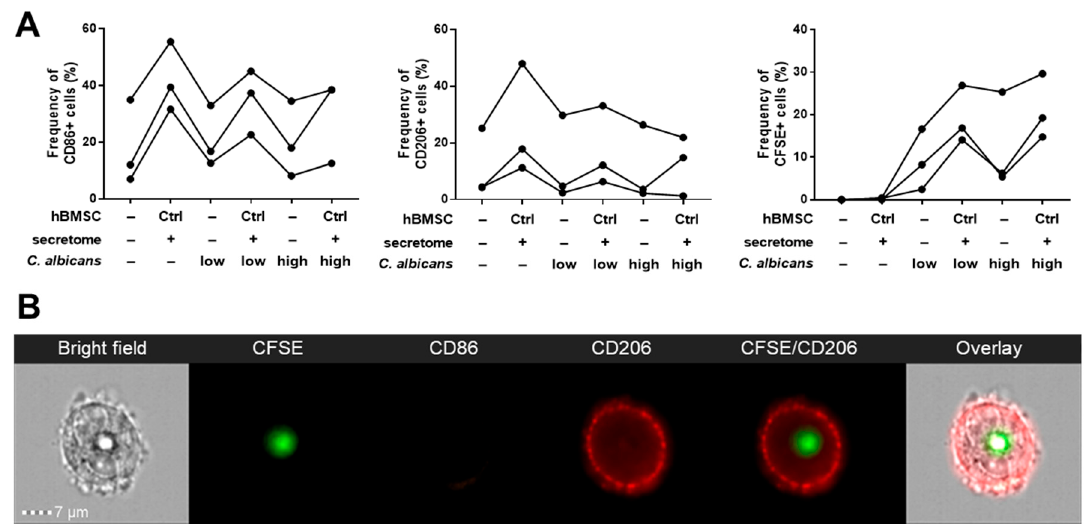
Figure 6. hBMSC secretome improves the C. albicans phagocytosis activity of Mreg-polarized macrophages in a CD206-mediated manner. ( A ) The frequency of CD86 and CD206 positive cells and the phagocytosis of CFSE-stained C. albicans were determined with imaging flow cytometry, n = 3 biological replicates. ( B ) A representative imaging flow cytometry image of a macrophage that has phagocytosed C. albicans . Low C. albicans concentration, 5 × 10 5 cells/well; high C. albicans concentration, 1.25 × 10 6 cells/well; CFSE, CFSE-stained C. albicans .